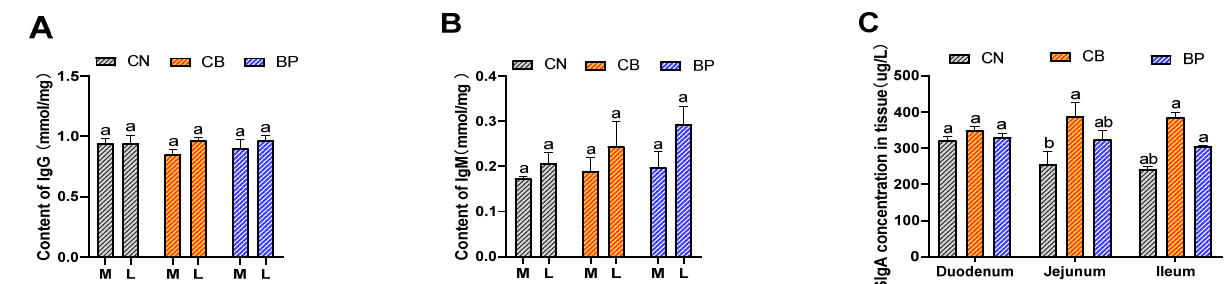
Figure 4. Effects of CN, CB, and BP on the morphology of the small intestinal mucosa in rabbits. ( A – C ) Villus length and crypt depth in the small intestinal mucosa, as well as the ratio of villus length to crypt depth. ( D ) H&E-stained section images (40 × ) of the jejunum and ileum. CN, rabbits were fed a basal diet; CB, rabbits were fed a basal diet supplemented with Clostridium butyricum ; BP, rabbits were fed a basal diet supplemented with a bacteriophage cocktail (values are expressed as the mean ± SE, n = 8; a,b Mean values within a row with unlike superscript letters were significantly different ( p < 0.05).